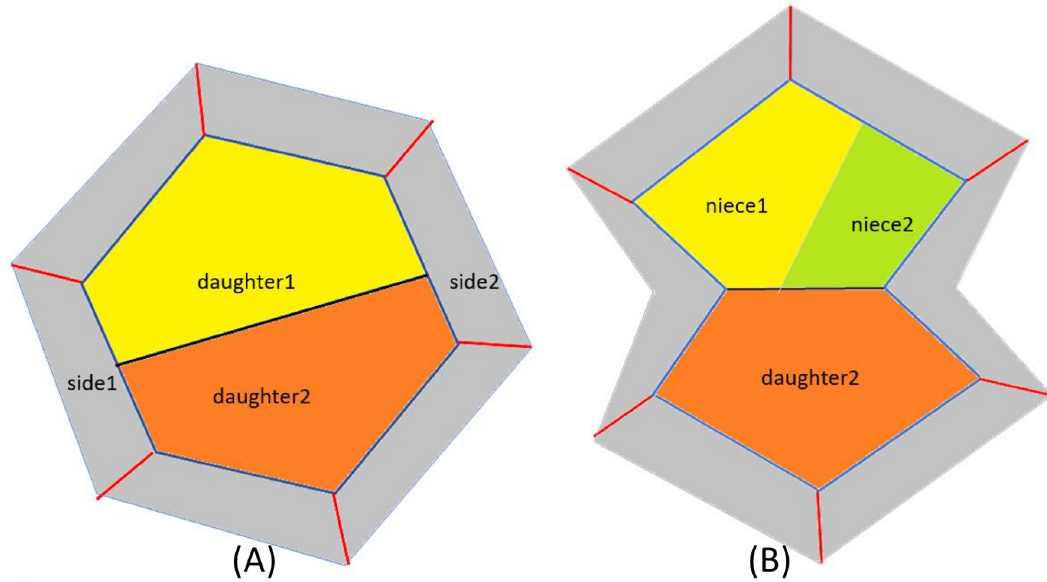
Fig 2. An example of two consecutive cell